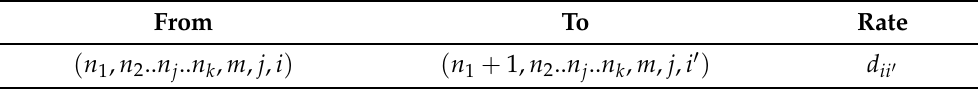
Table 6. Transitions and corresponding rates of transition within level n (i.e., n 1 ≥ a ). Sl. No From To